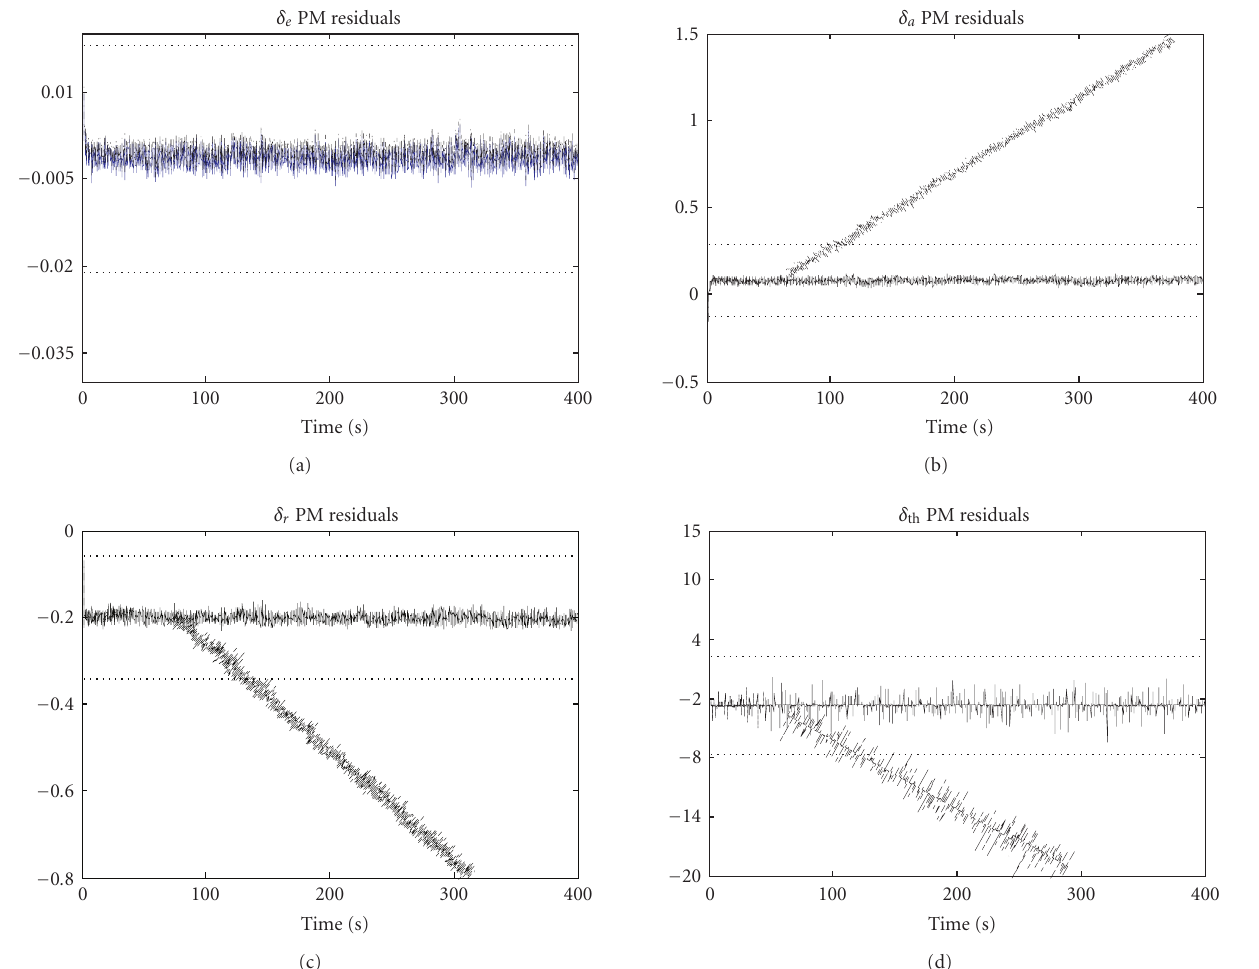
Figure 1: PM residuals for the 1st input sensor ramp fault f c